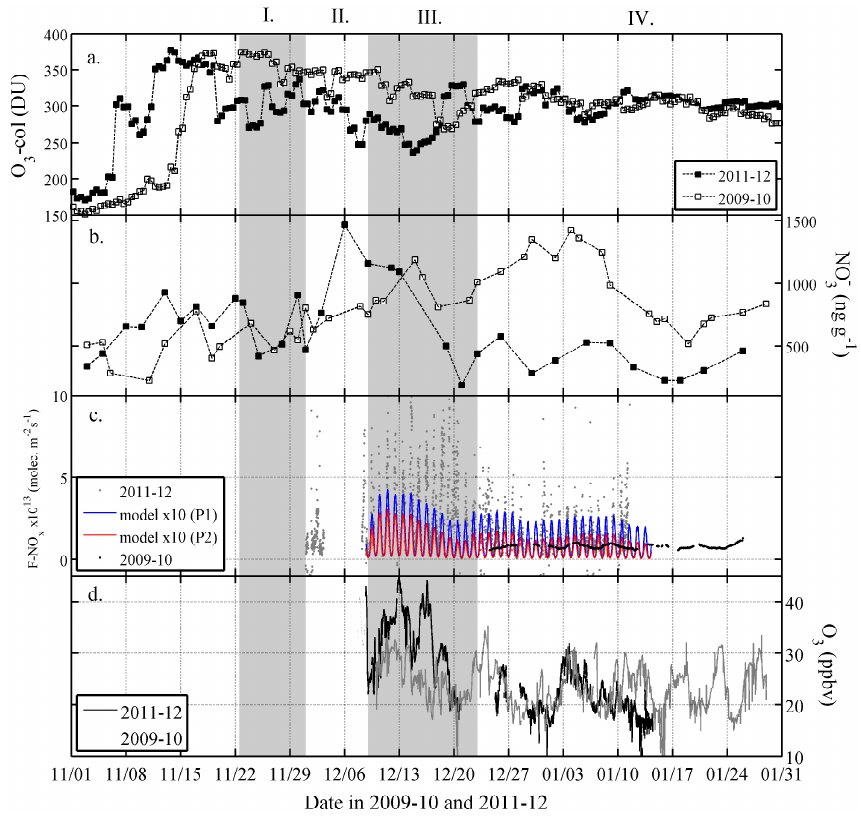
Figure 7. (a) Total column O 3 above Dome C. (b) NO − concentrations in the skin layer of surface snow (top 0.5cm). (c) Observational 3 estimates of NO x flux ( F NO ) between 0.01 and 1m (10min averages) and modelled F NO (multiplied by 10) based on NO − in the skin 3 x 2 layer and depth profiles observed at 100m (P1) and 5km (P2) distance from the lab shelter (see Fig. 3a); the 1-day running mean of F NO x during 2009–2010 is shown for comparison (from Frey et al., 2013). (d) Atmospheric O 3 mixing ratios. Highlighted periods I–IV as referred to in the text and Table